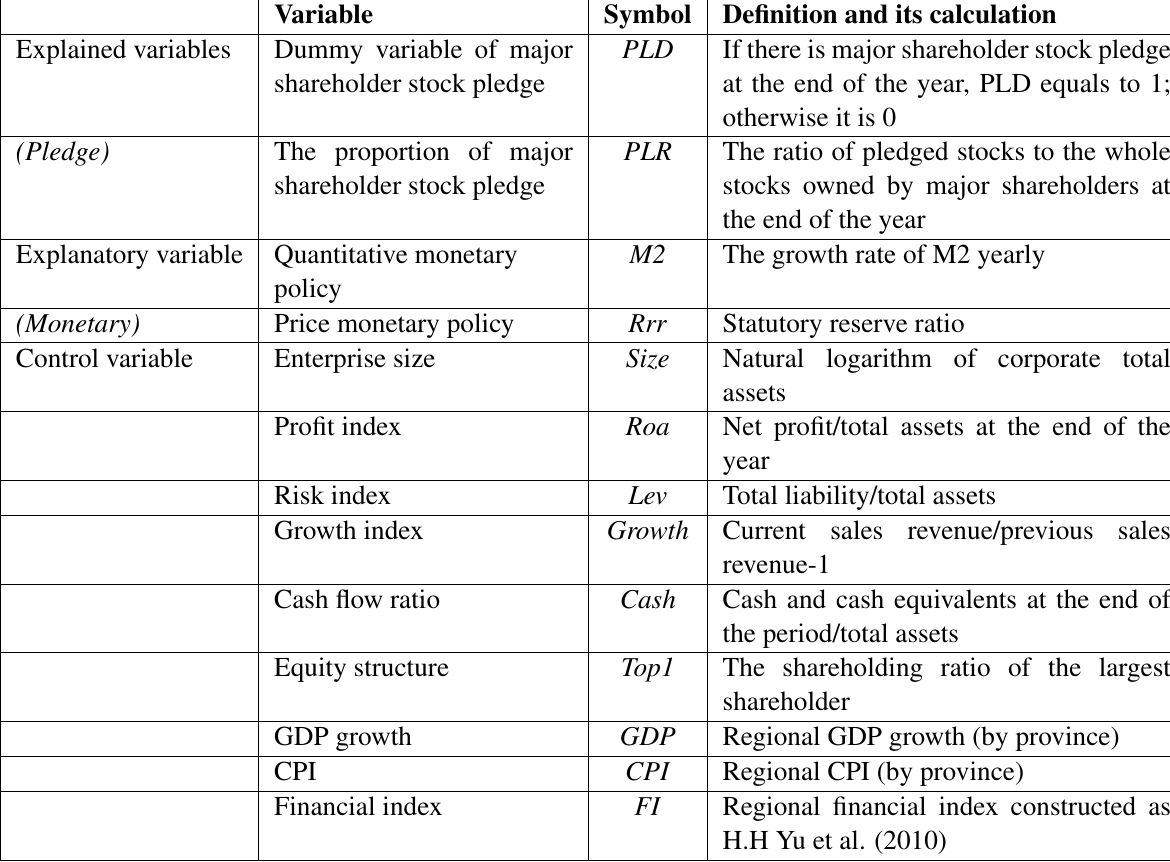
Table 2 Major variable definition and its